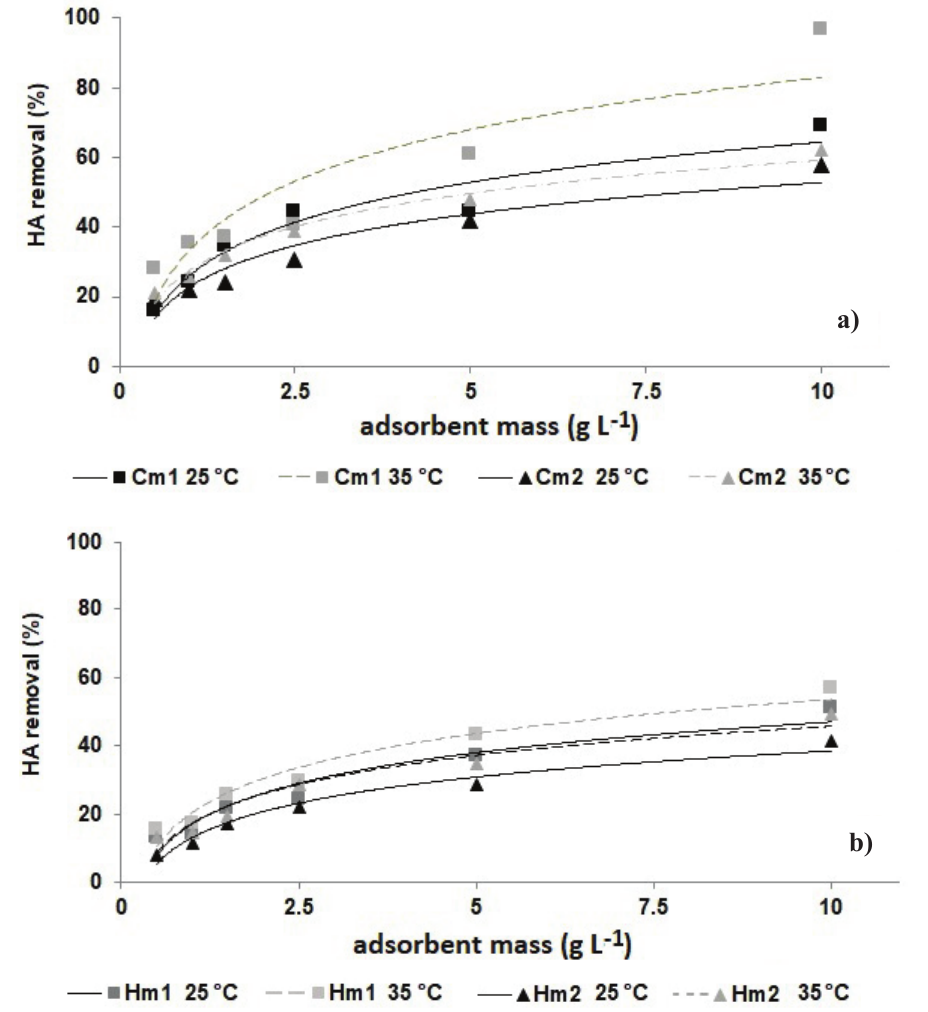
Fig. 3 – Effects of adsorbent mass (a) Cm1 and Cm2, and (b) Hm1 and Hm2 on HA removal